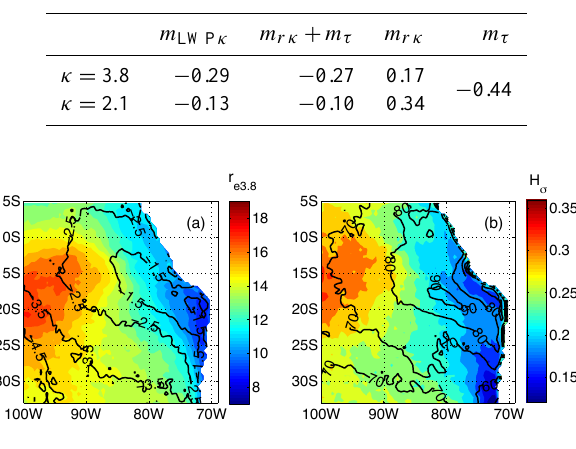
Fig. 1. Average fields during the period of study: (a) r e 3 . 8 (color) Fig. 1: Average fields during the period of study: a) r e3.8 (color) and Δ r e = r e3.8 -r e2.1 448 and 1r e = r e 3 . 8 − r e 2 . 1 (contours), (b) H σ (colors) and cloud frac- (contours), b) H σ (colors) and cloud fractions (contours). The continent is represented by 449 tions (contours). The continent is represented by the white region. the white region. 450